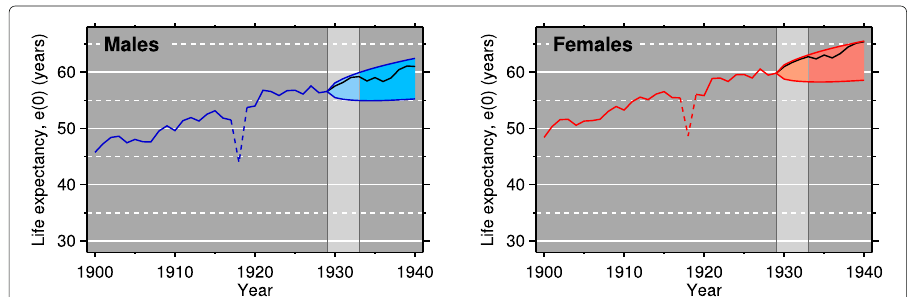
Fig. 2 All races life expectancy, 1900–1940, USA. Males (left) and females (right). With Lee-Carter projection interval for 1930–1940, based on 1900–1929. Due to the influenza pandemic, 1918 was omitted from the variance calculation (dashed